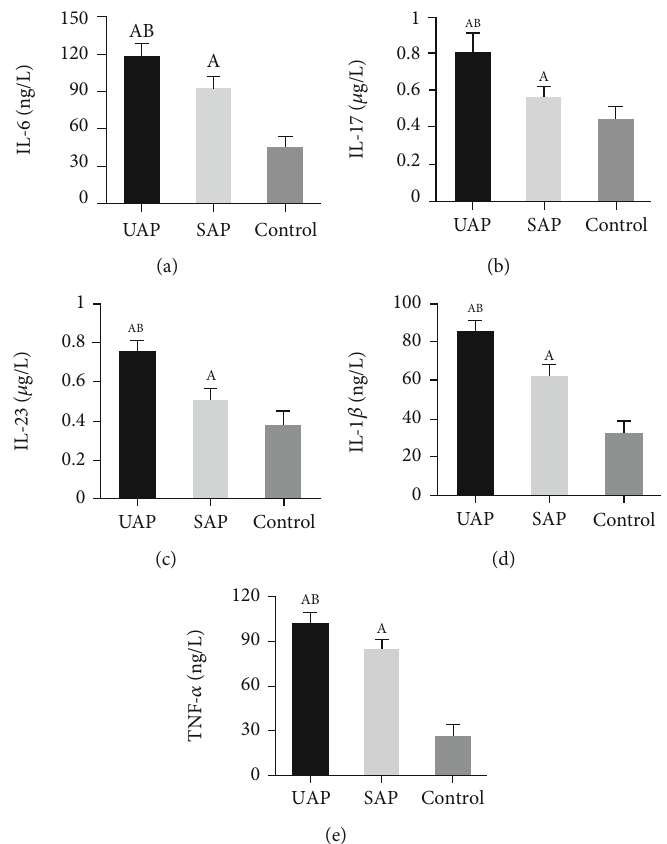
Figure 4: Comparison of serum in fl ammatory factor levels in patients. (a – e) The comparison of IL-6, IL-17, IL-23, IL-1 β , and TNF- α , respectively. A and B suggested the di ff erence was obvious to the control group and SAP group, respectively ( P < 0 : 05 ).